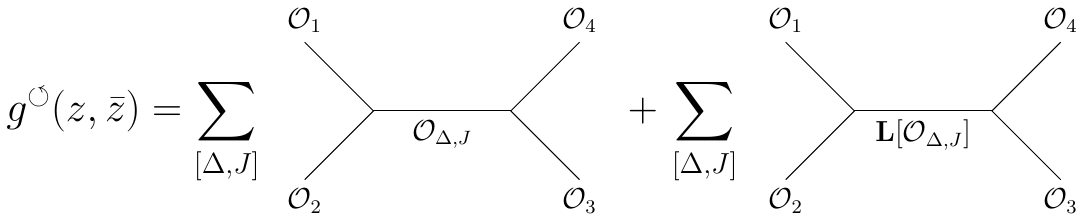
Figure 6 . The conformal block decomposition of the four-point function in the Regge limit. Light- ray operators L [ O (cid:1) ;J ] as well as local primaries O (cid:1) ;J appear as intermediate states. Compared with (2.5), this behavior is the same as the conformal block carrying the